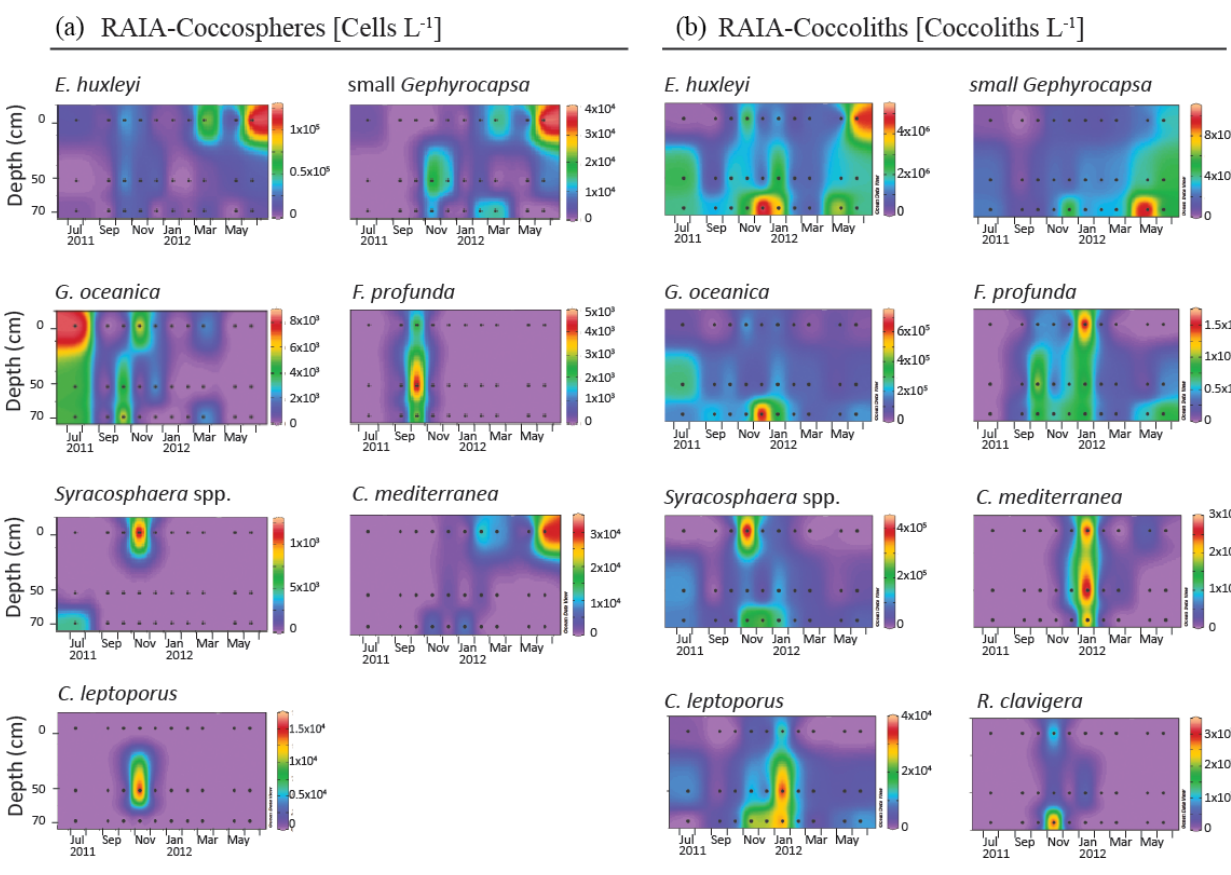
Figure 6. Absolute abundance of major species of coccospheres ( a , given in cellsL − 1 ) and coccoliths ( b , given in coccolithsL − 1 ) in RAIA station. Black dots represent the sampling month and depth. Note that each colour bar has been scaled to the maximum and minimum values of its corresponding